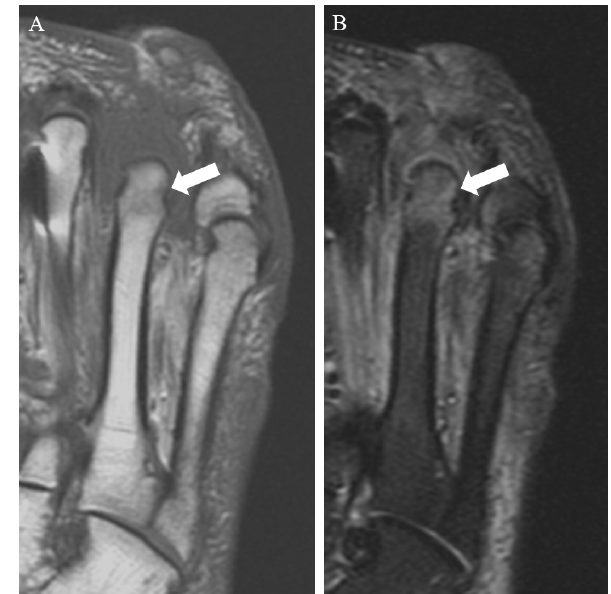
Figure 3. Coronal T1 (a) and STIR (b) images of the forefoot in a 45-year-old male with prior fourth- and fifth-toe amputations and recurrent ulcer. There is hazy reticulated T1 hypointense sig- nal within the fourth metatarsal head, with relative preservation of marrow fat signal (arrow in panel a ). STIR images demonstrate hy- perintensity in this area (arrow in panel b